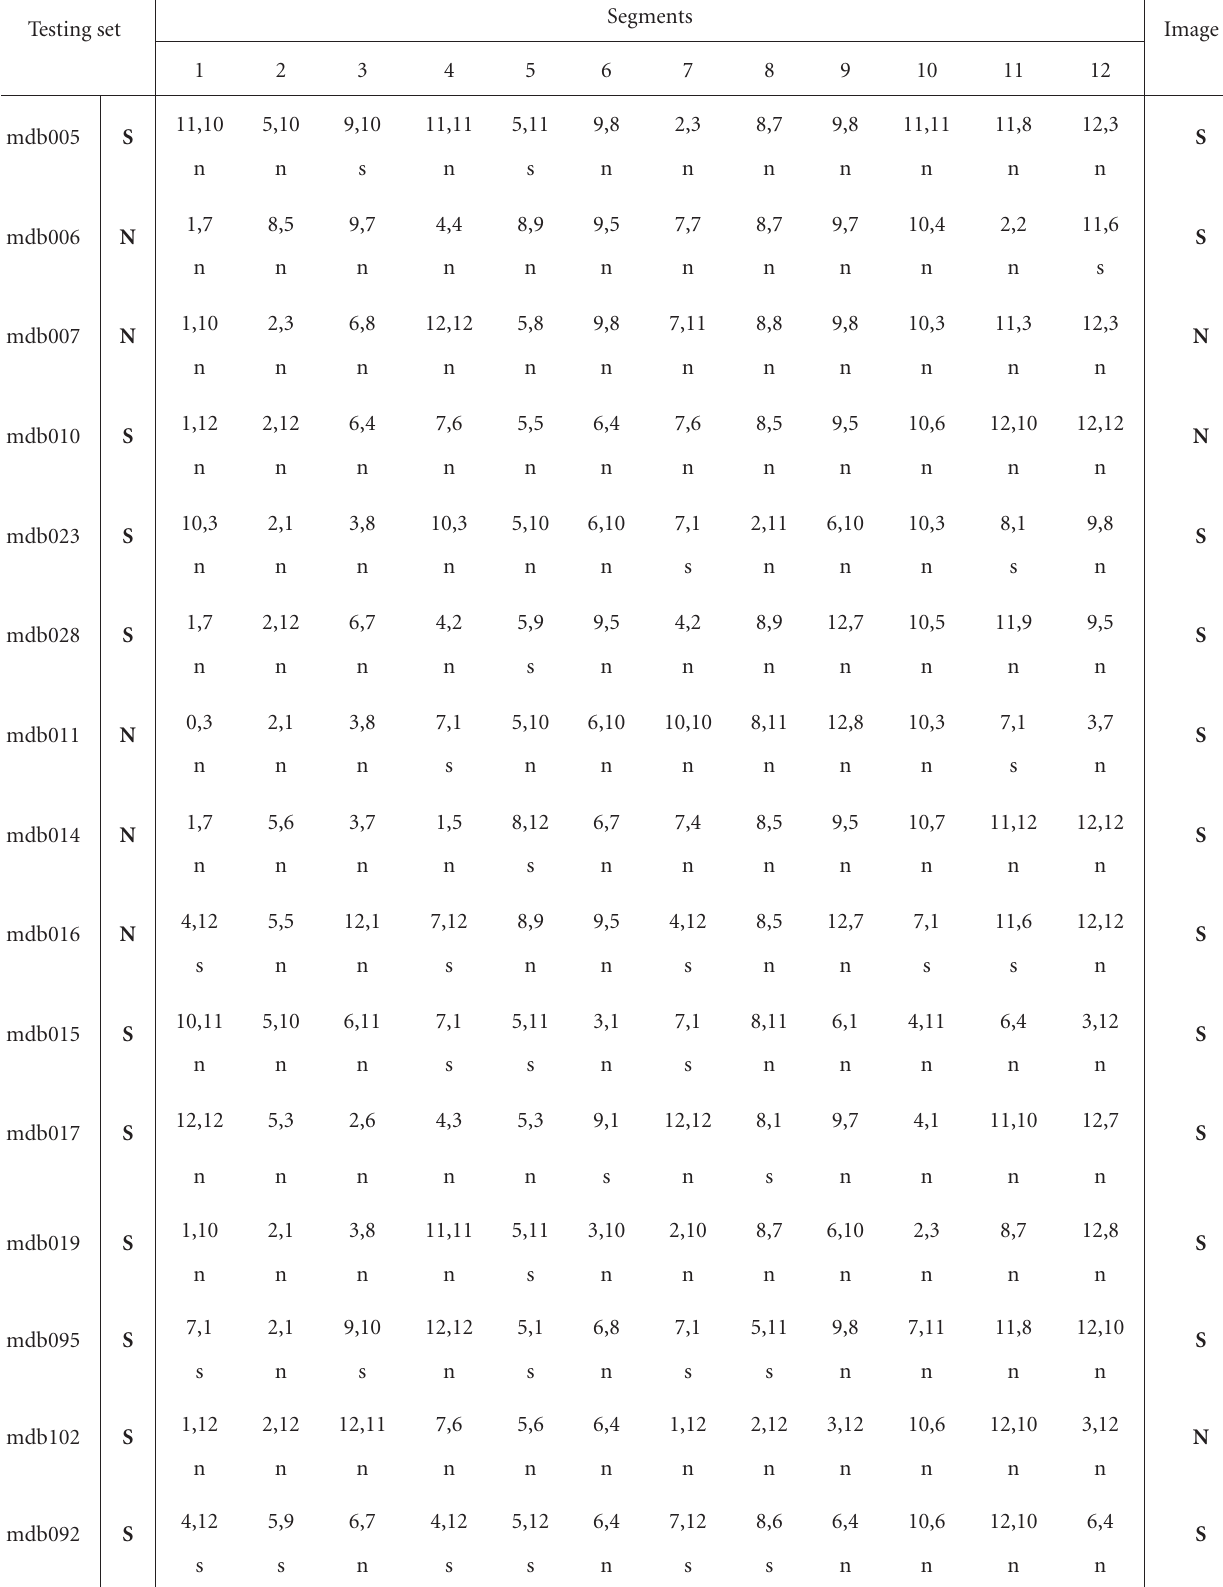
Table 2: Results using block processing with Euclidean distance. Note: first number indicates the block number and second one signifies the image number in training